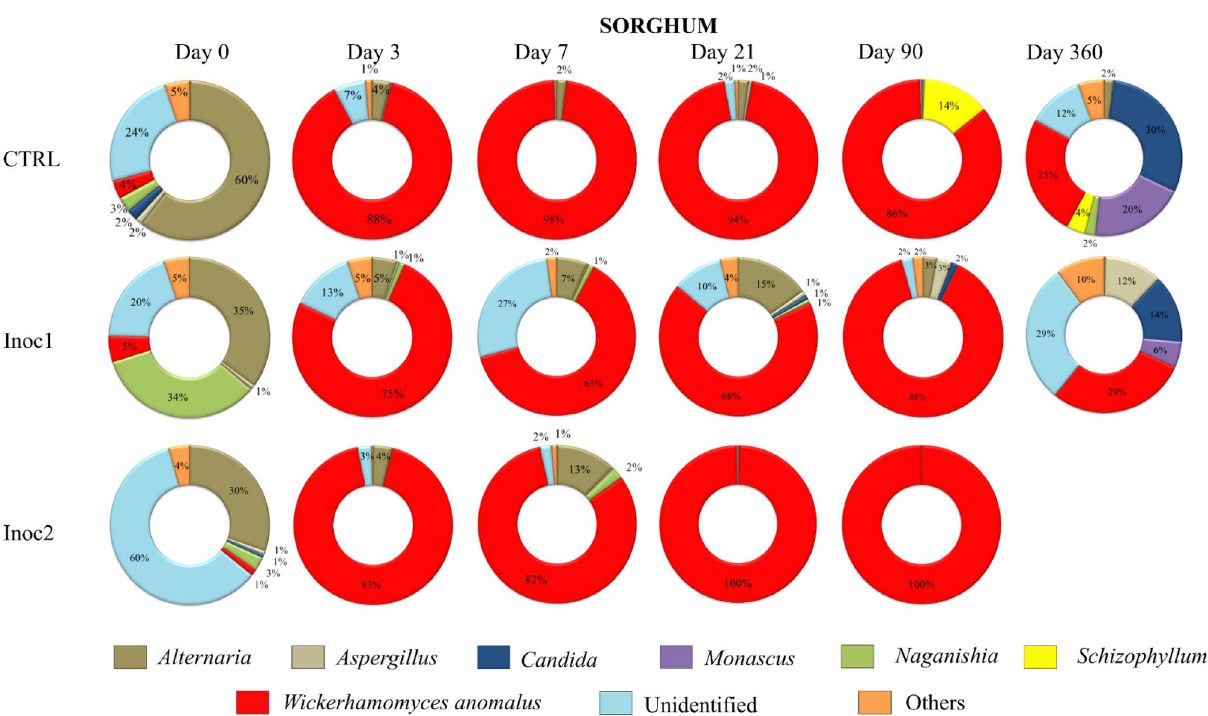
Figure 8. Main genera dynamics (%) of fungal communities of rehydrated sorghum grain silages after 0, 3, 7, 21, 90 and 360 days of fermentation. CTRL non-inoculated, Inoc1 Lactobacillus plantarum and Propionibacterium acidipropionici , Inoc2 Lactobacillus buchneri